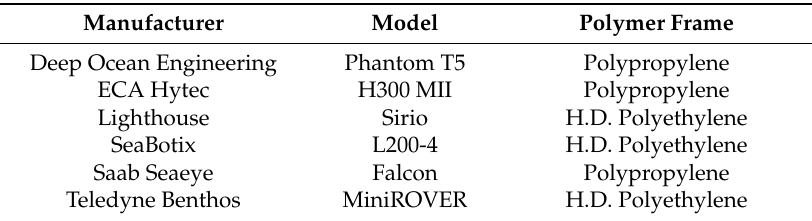
Table 2. Inspection-class ROV polymer frame